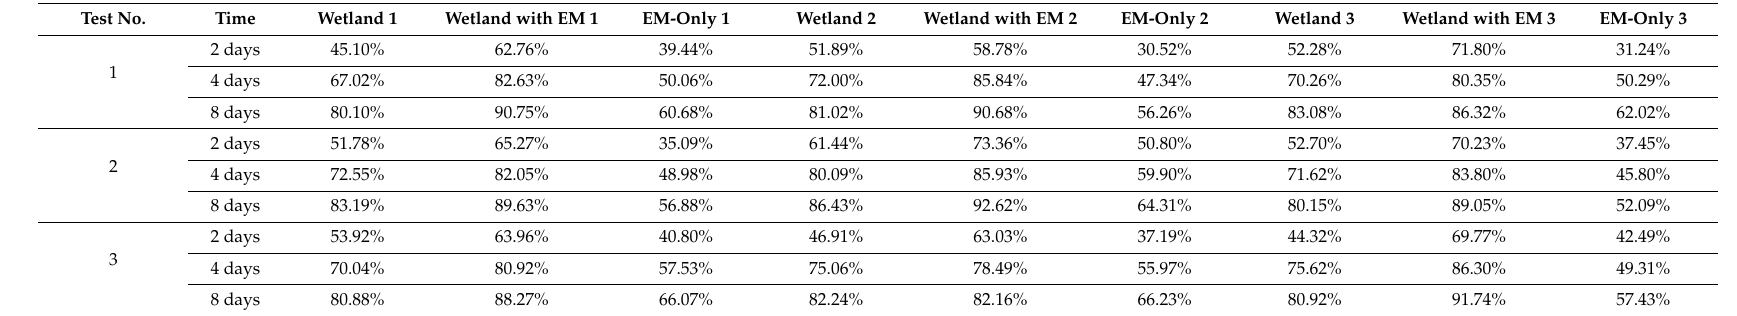
− Table 4. NO -N concentration reduction rates of in wetlands over 8 3